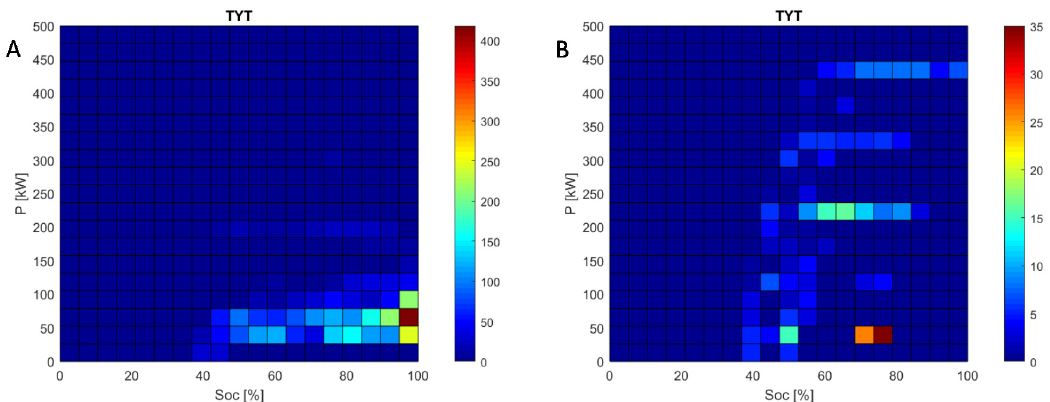
Figure 7. Map of “attendance” of the storage unit operation states during charging ( A ) and discharging ( B ) for 1 min data; the color scale represents a value proportional to the operation time in the P and SoC range.